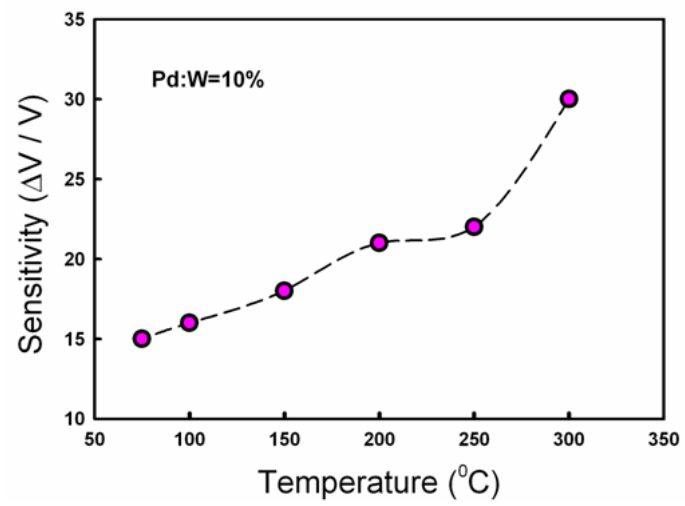
Figure 5. The sensitivity of the Pd-modified WO a function of operating